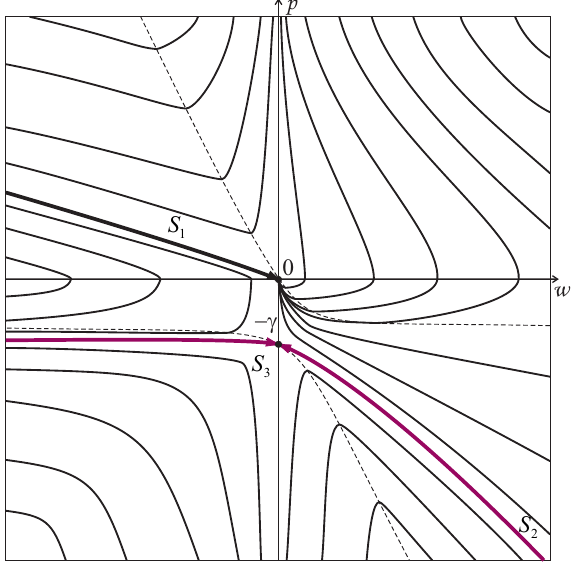
Figure 2. Phase portrait for γ > α .